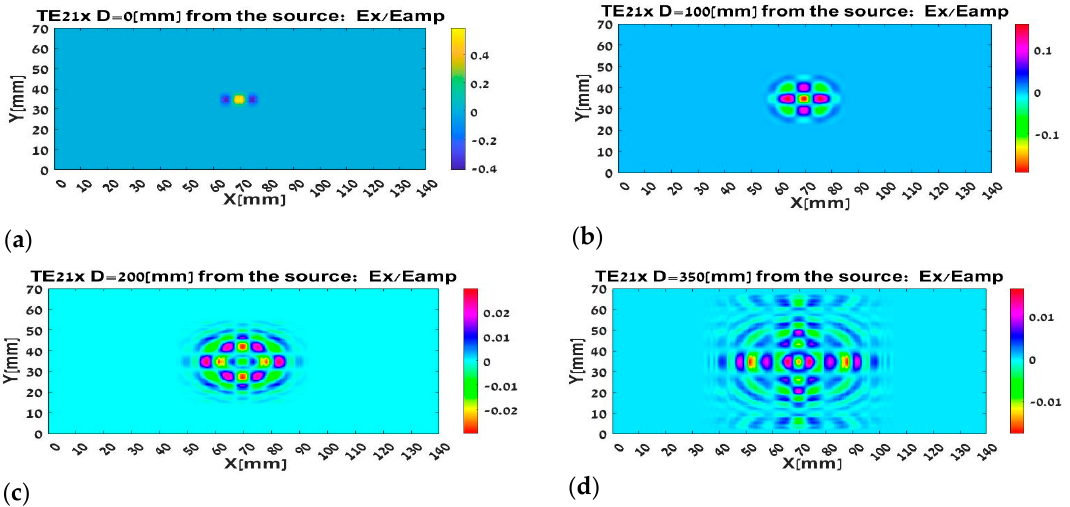
Figure 6. The TE 21 mode propagation in term of the rays: ( a ) at the out of the waveguide; ( b ) after passing 100 mm, and ( c ) after passing 200 mm, and ( d ) after passing 350 mm.